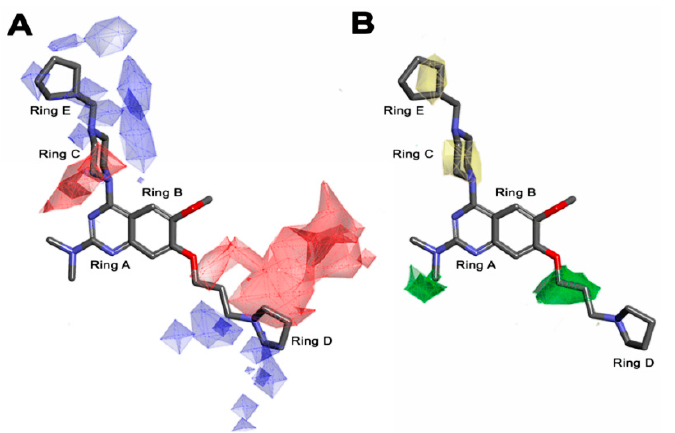
Figure 11. Pictorial representation of the 3D ‐ QSAR model coefficients on ( A ) electrostatic and ( B ) Van der Waals grids mapping quinazoline core template molecule 14.